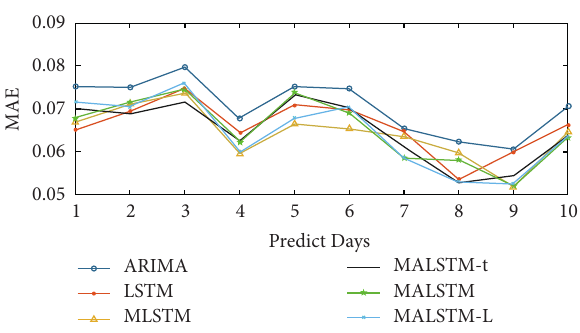
Figure 5: Experimental results of MAE. Table 3: The RMSE results of the market counts prediction in the next ten